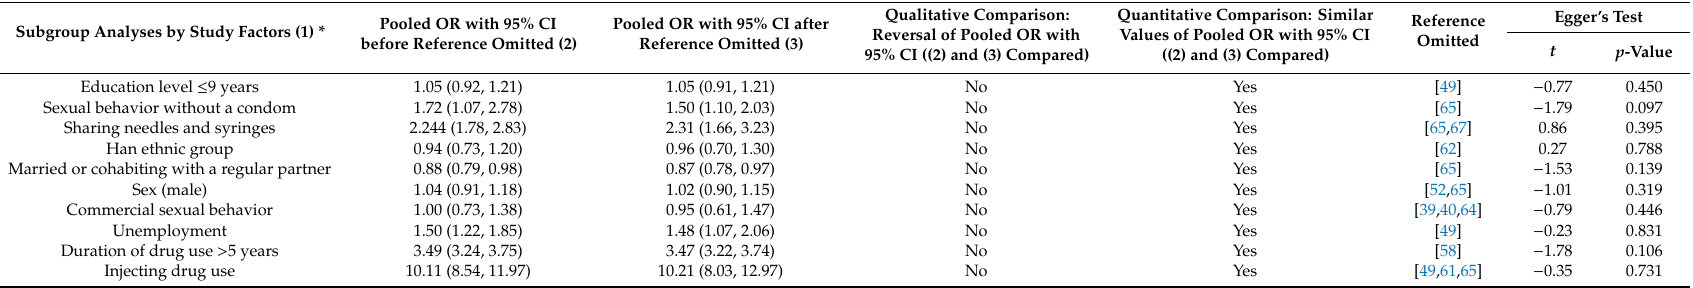
Table 2. The subgroup characteristics of the study factors associated with HCV infection among drug users after omitting the studies with the maximum weight value for the ORs in the subgroup analysis and the results of Egger’s test. Subgroup Analyses by Study Factors (1) * Pooled OR with 95% CI